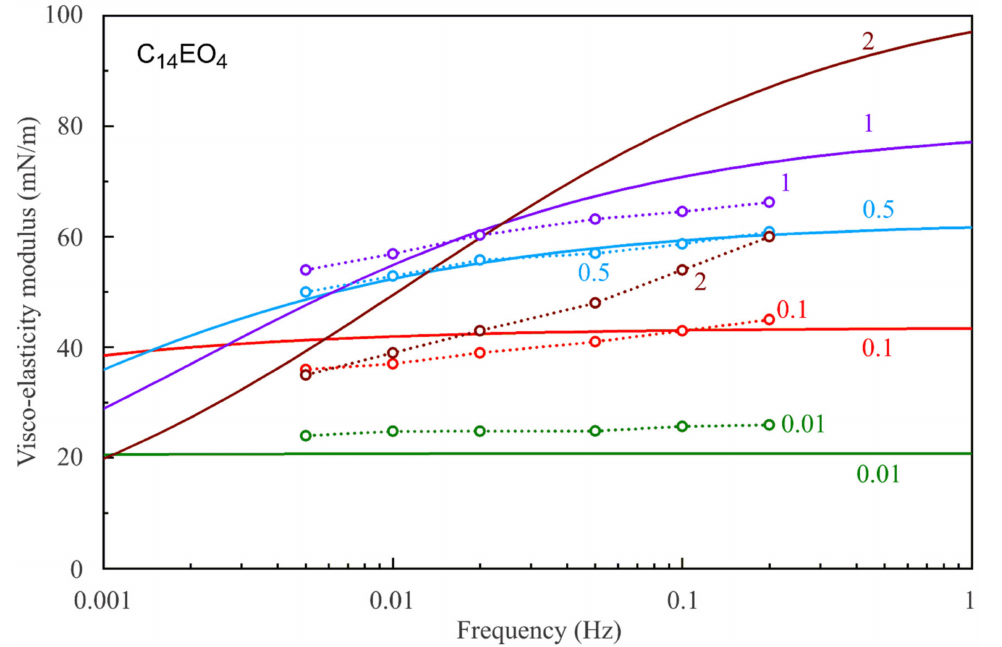
Figure 11. Experimental visco-elasticity modulus vs. frequency for C 14 EO 4 solutions of different concentrations (0.01, 0.1, 0.5, 1.0, and 2 µ mol/L, as indicated by numbers) and the respective theoretical curves calculated with the LvT equation, Equation (8), with E 0 (c) and ω D (c) calculated by using the reorientation model, Equations (1)–(6), with the parameter values presented in Table 1. Dotted lines are guides for the eye.